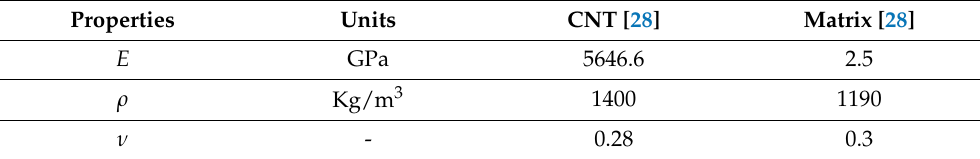
( ) (cid:112) 2 1 R V E ω ρ Ω = − ( 1 − V 2 ) ρ / E